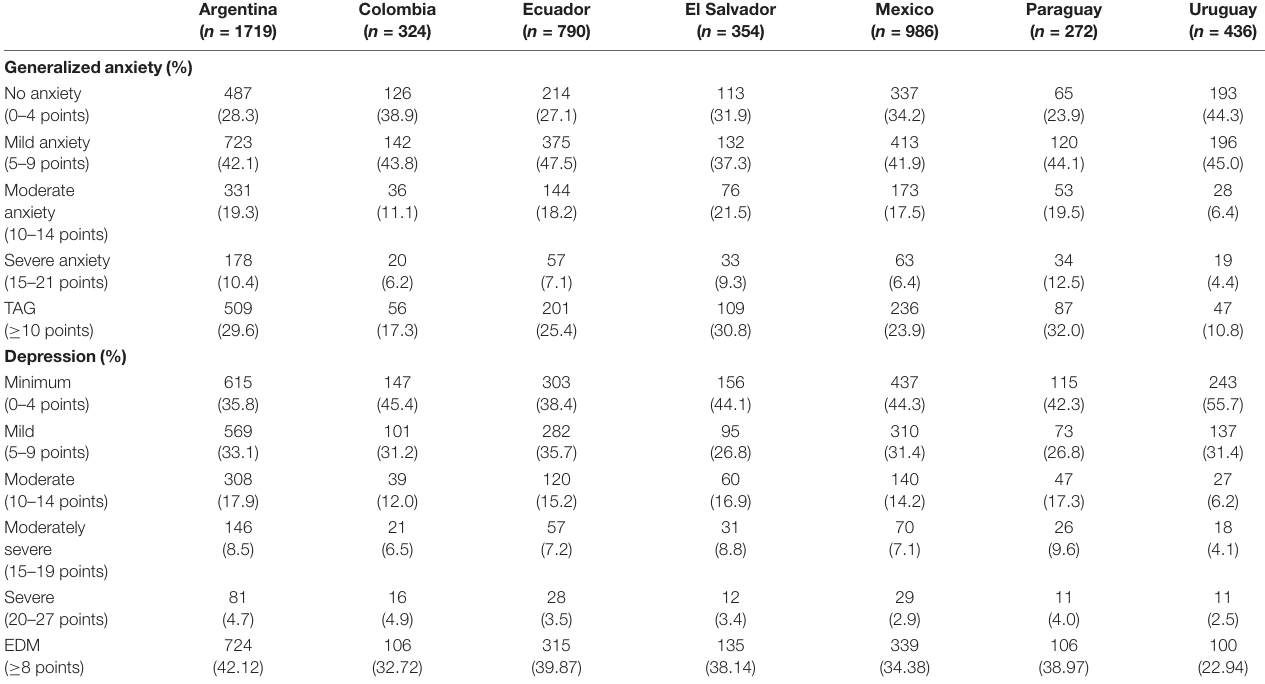
TABLE 3 | Levels of generalized anxiety and depression.